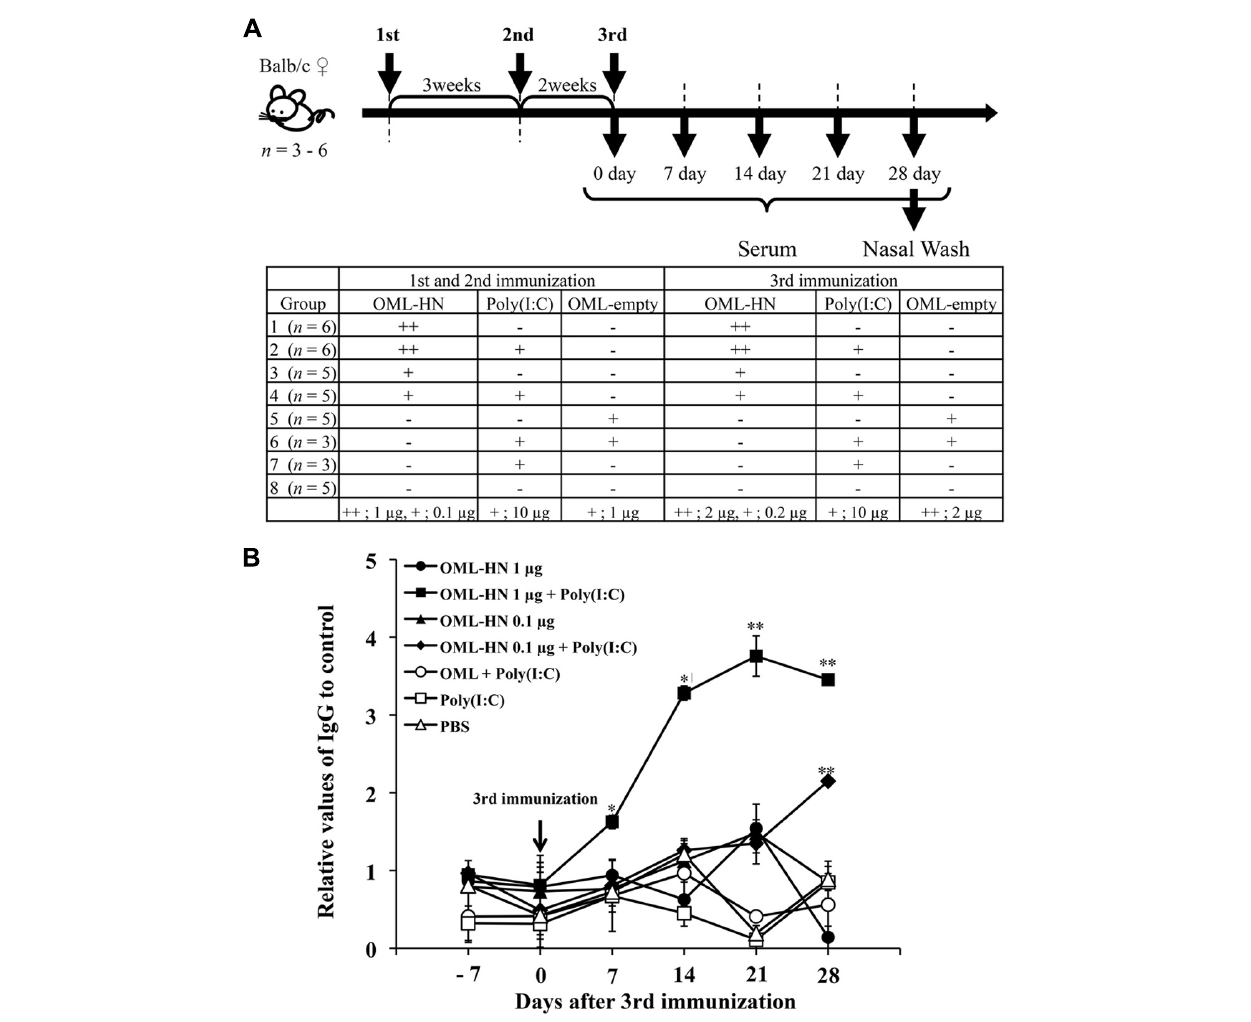
FIGURE 2 | Serum antibody responses in mice immunized with OML-HPIV3-HN. (A) Balb/c mice were immunized with the indicated antigens and/or adjuvant on days 0, 21, 35 as described in the Materials and Methods. Serum was collected from each mouse on days 7, 14, 21, and 28